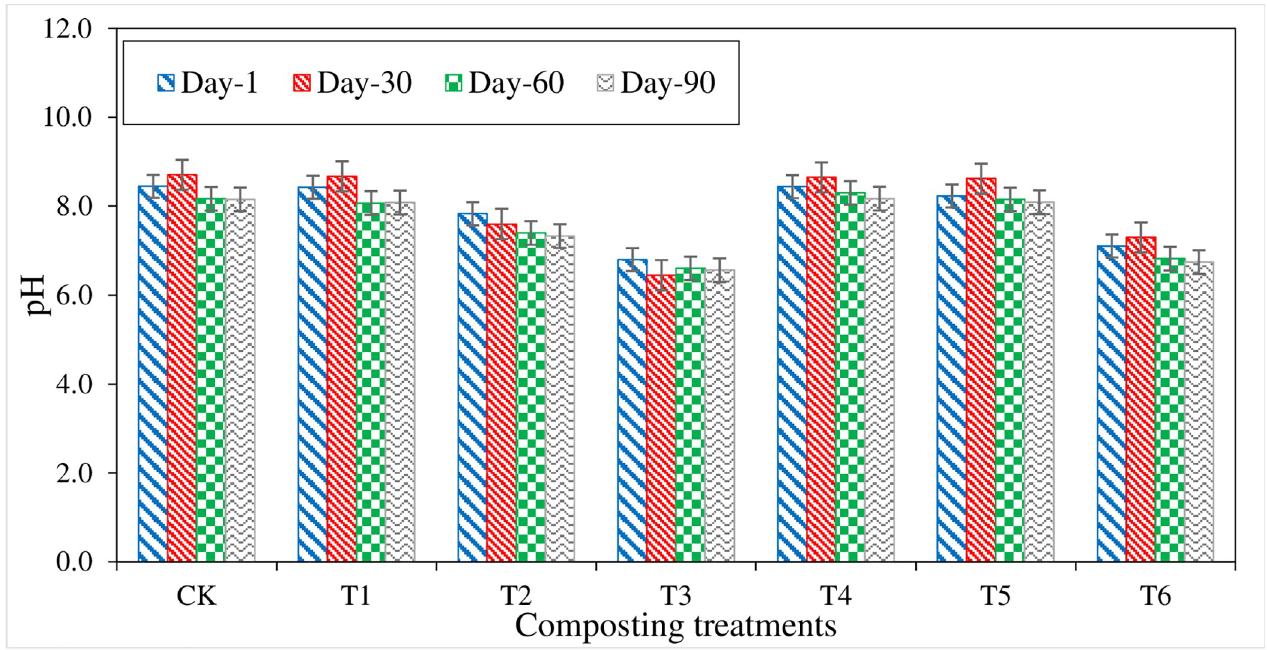
Fig 2 exhibited that the pH values varied throughout the composting process. Initially, pH ranges from 6.8 to 8.7 in all treatments. During the initial 30 days of composting, all the